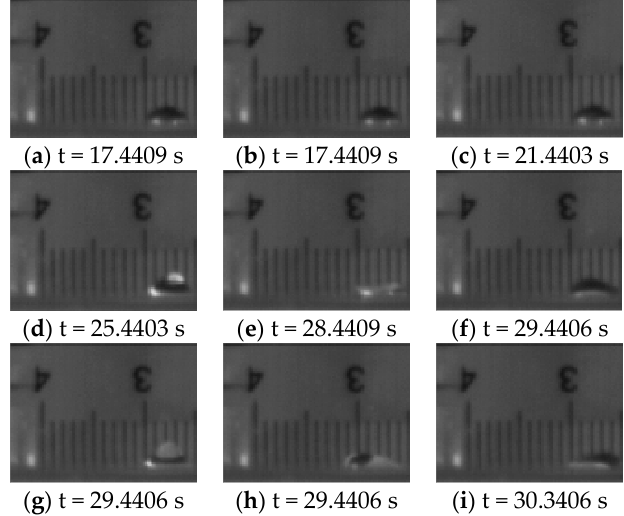
Figure 18. The deformation characteristics of droplet under AC power source.